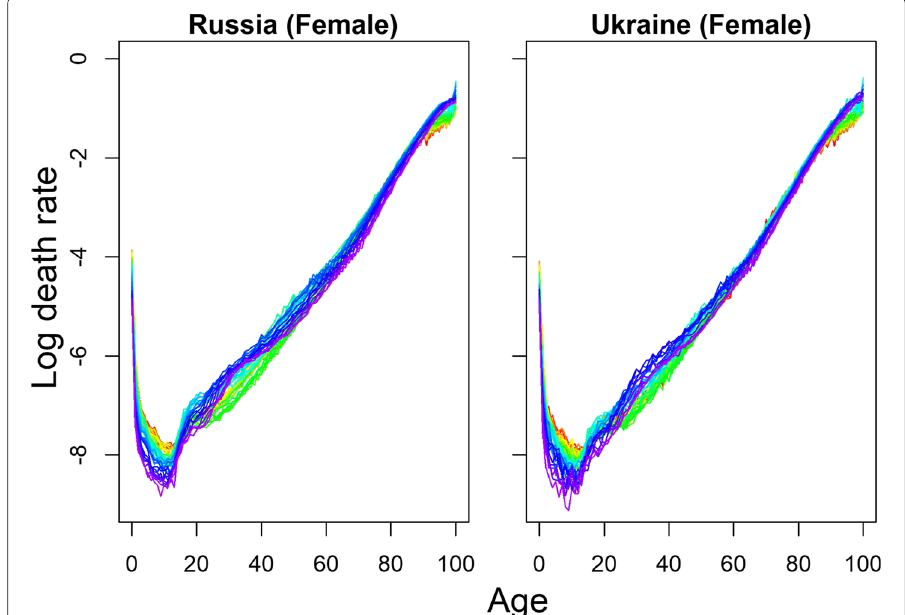
Table 3 One-step-ahead forecast bias of the fitted models in terms of MAE Country LC LC P LM BMS HU HU R HU W LL –